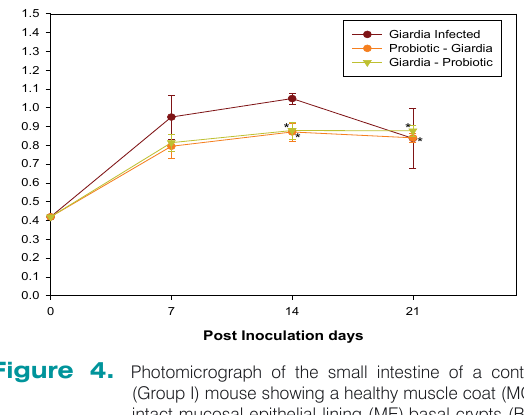
Figure 4. Photomicrograph of the small intestine of a control (Group I) mouse showing a healthy muscle coat (MC), intact mucosal epithelial lining (ME),basal crypts (BC) and normal morphology of microvilli, ( H & E stain, 100 X ).